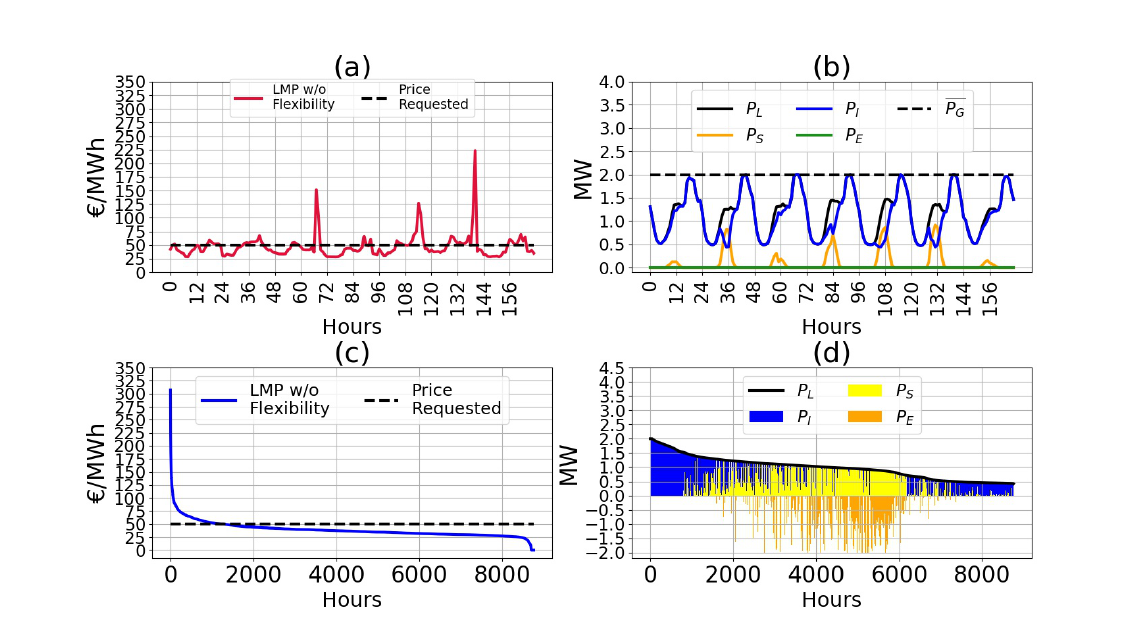
Figure 4. Demand, generation, and prices in the reference case. ( a ) Local electricity price for a typical week. ( b ) Demand and generation in the same week. ( c ) Price duration curve. ( d ) Load duration